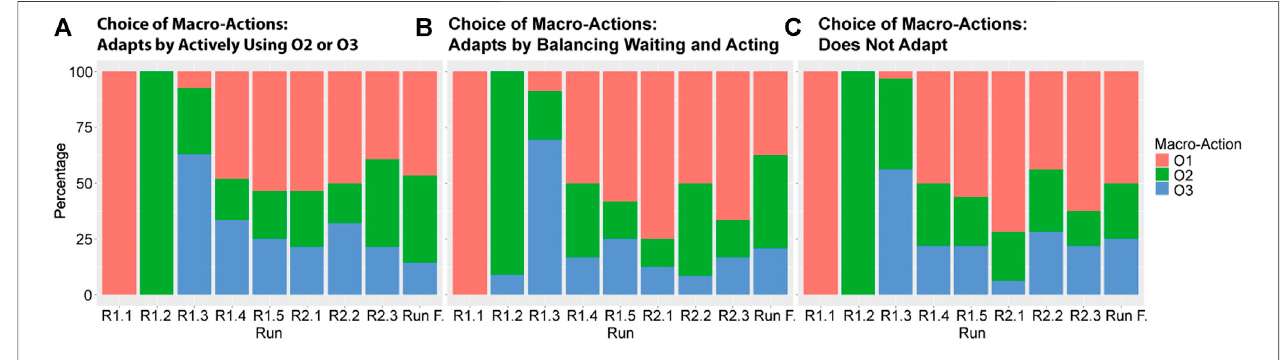
FIGURE 10 | An overview of how often certain Macro-actions were chosen by the robot across all participants per run, split up by the level adaptation the participant showed: (A) shows participants who adapted by actively using O2 — passive large rocks and/or O3 — breaking , (B) shows participants who adapted by balancing waiting and acting, and (C) shows participants who did not